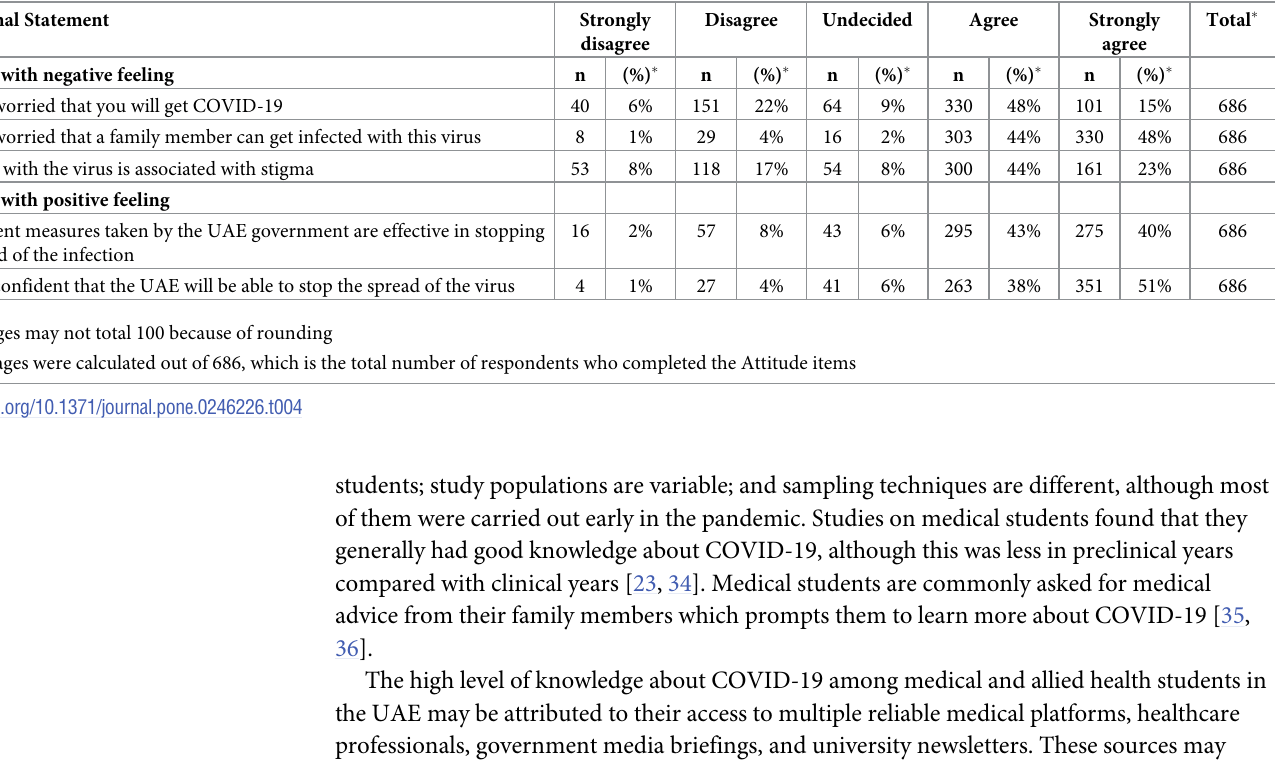
Table 4. Responses to the survey on COVID-19 attitude.